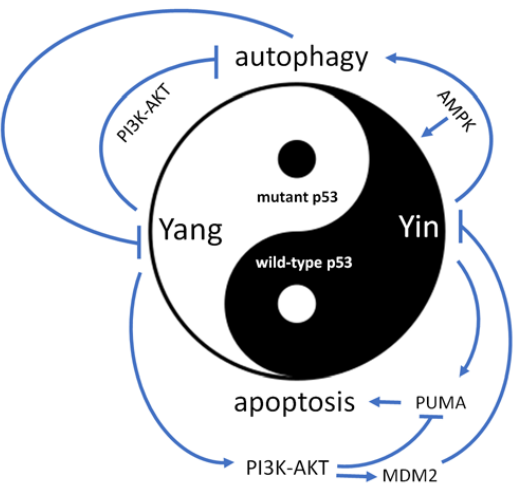
Figure 2. The competition between wild type and mutant p53 plays a crucial role in tumor progression. While wild type p53 acts as a negative factor (Yin), mutant p53 serves as a positive factor (Yang) in cancer development. Mutant p53 can activate the PI3K-AKT signaling pathway, which induces